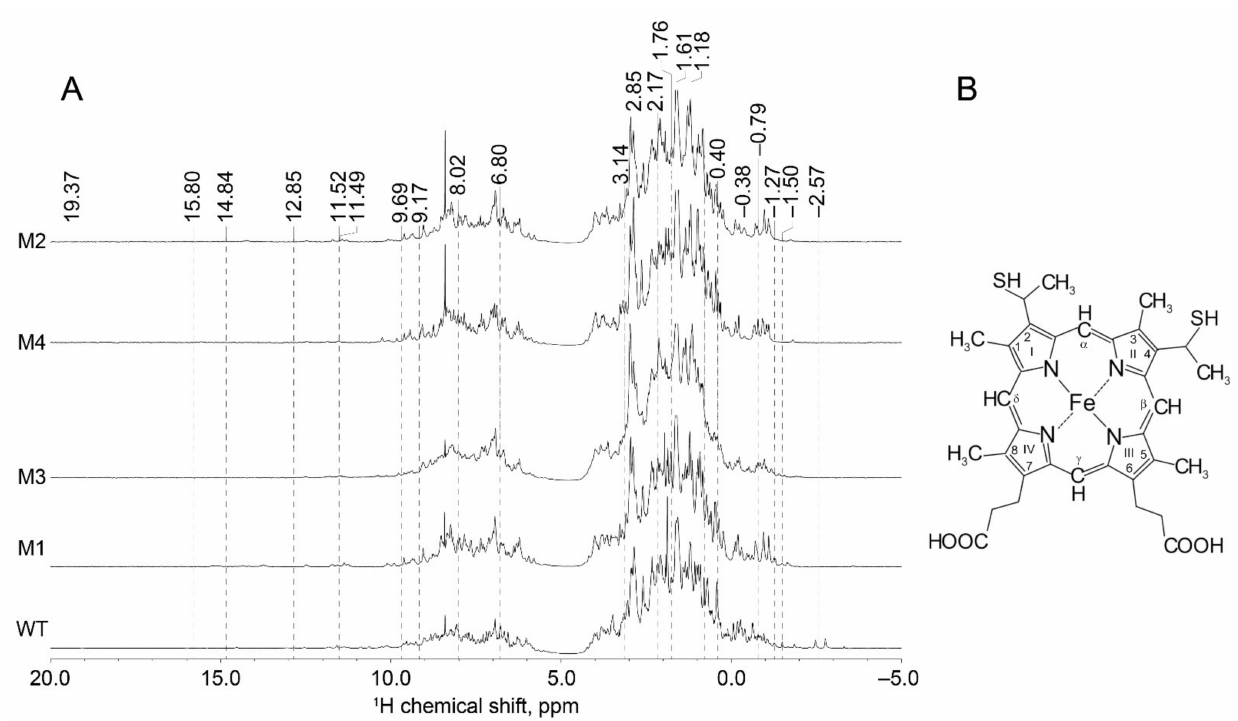
Figure 3. ( A ) The 1 H-NMR spectra of cytochrome c (WT) and its mutant variants (M1-T78N/K79Y/M80I/I81M/F82N, M2-T78S/K79P, M3-I81Y/A83Y/G84N, M4-P76I/G77L/I81L/F82L); ( B ) Structural formula of heme c with numeration of C